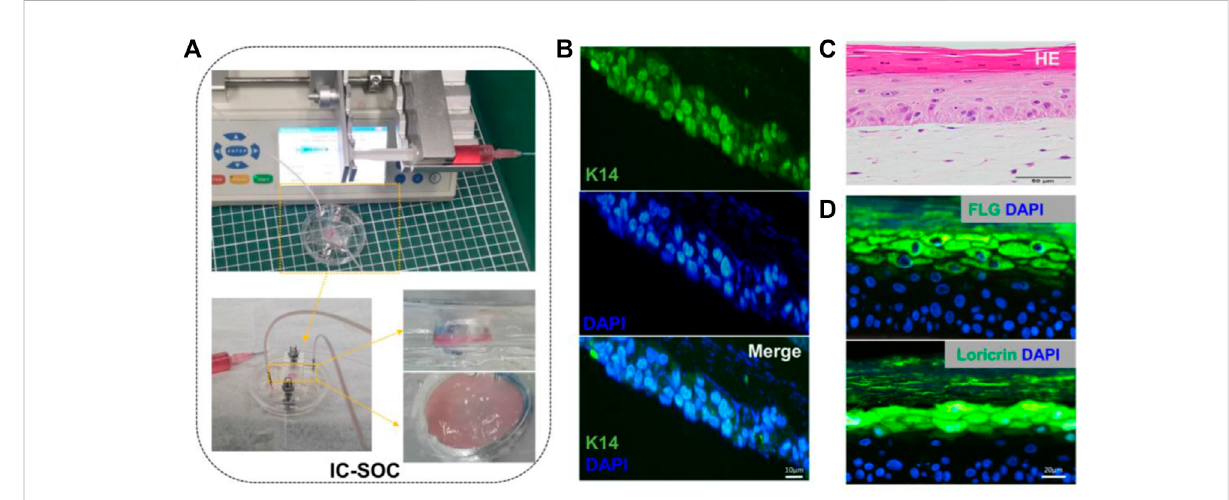
FIGURE 2 Morphology and cell characterization of IC-SoC. (A) Upper part shows the skin cultured in IC-SoC, the lower part is the enlarged skin in the culturechamber,andtherightpartshowsthesideviewandthetopviewoftheskin. (B)